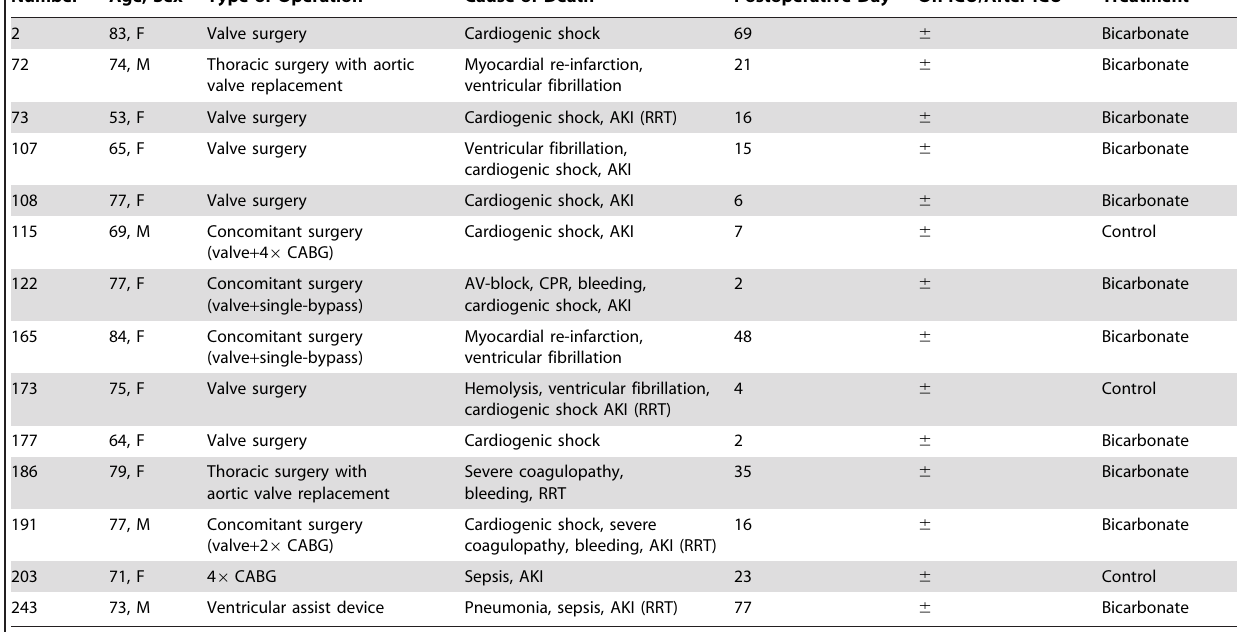
Table 8. Cause of in-hospital